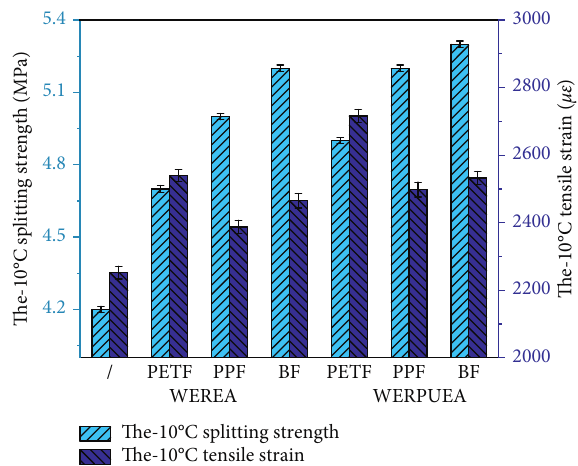
Figure 10: The − 10 ° C splitting strength and tensile strain.